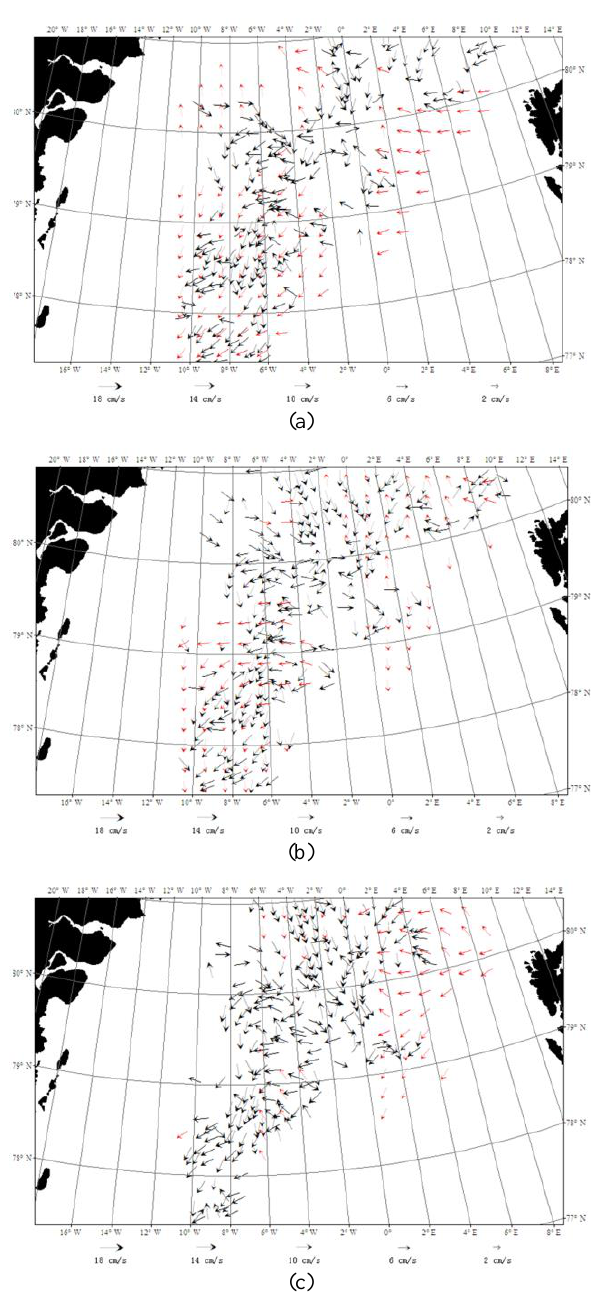
Fig.5 The pack ice motion vectors tracked from (a) the first image pair, (b) the second image pair and (c) the third image pair (as more fully detailed in Table 3). The black arrow shows the pack ice motion vector traced by FY-3/MERSI and the red arrow shows sea ice motion vector provided by NSIDC.The longer arrows represent quicker motion velocity.